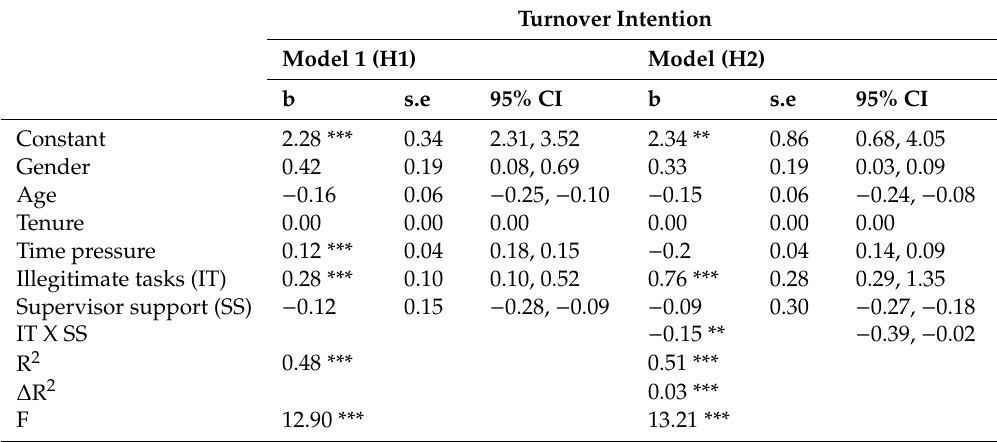
Table 2. Regression analyses (hypothesis 1 and